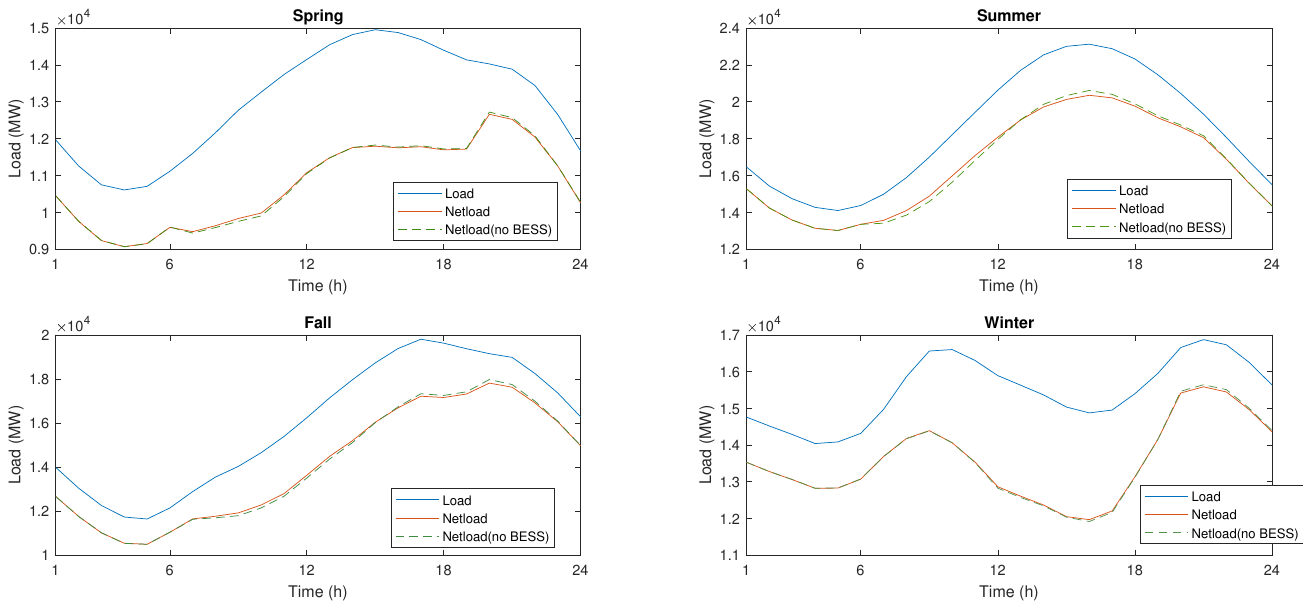
Figure 4. Net load curves for the seasons. The dotted lines indicate net loads without BESSs.